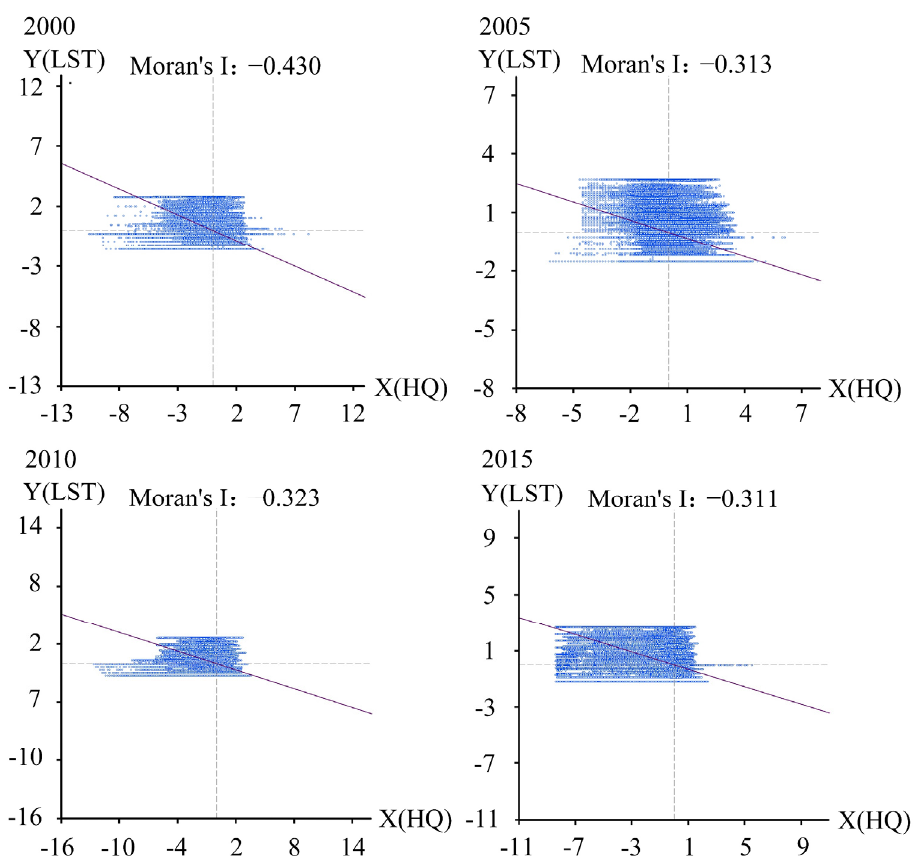
Figure 7. The Moran’s I scatter diagram of LST and habitat quality during the different periods from 2000 to 2015.